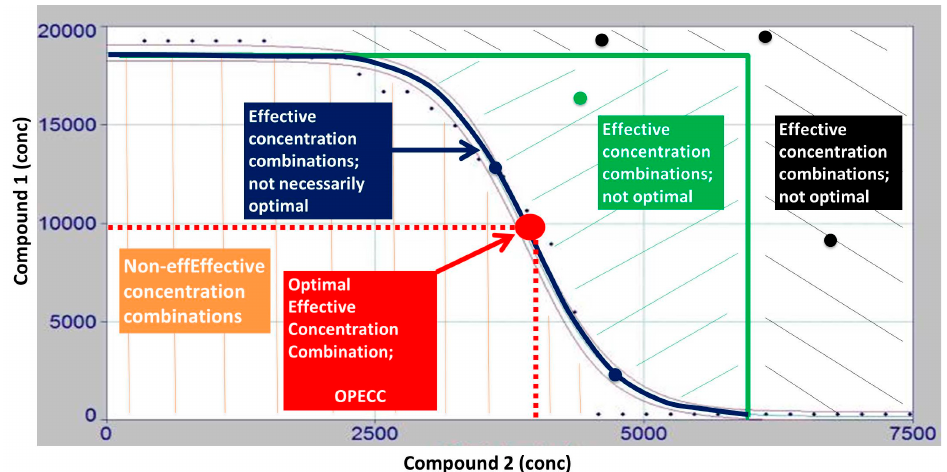
Figure 3. Discussion of the OPECC ( Optimal Effective Concentration Combination ) calculation process. The two-dimensional intersection line of the fitted three-dimensional curve ( z = f (x,y) ) with the x-y (concentration) plane (see Figure 2), i.e., the curve in the concentration plane resulting from the equation z = f (x,y) = 0 and here shown as a blue line, depicts the shift from non-turbid (z = ODn = 0, blue line; green and black areas, no growth, i.e., effective concentration combinations) to turbid (z = ODn > 0, brown area; growth, i.e., non-effective concentration combinations) wells (see Figure 2). Concentration pairs in the brown area show growth of the bacteria, and are, therefore, non-effective. For all concentration pairs in the green or black range (effective concentration pairs, exemplary dots in respective colors), both concentrations can be lowered down to the blue line, and the resulting, in both concentrations lower concentration pair, remains effective. Thus, the search for an optimal effective concentration pair is reduced to the blue line. On the blue line, it is true that a decrease in one of the two concentrations necessarily results in an increase in the other if the resulting concentration pair is to remain effective. The balance between the decrease in one concentration and the increase in the other is optimally achieved at the inflection point of the curve. Therefore, this inflection point is named the optimal effective concentration combination (OPECC).